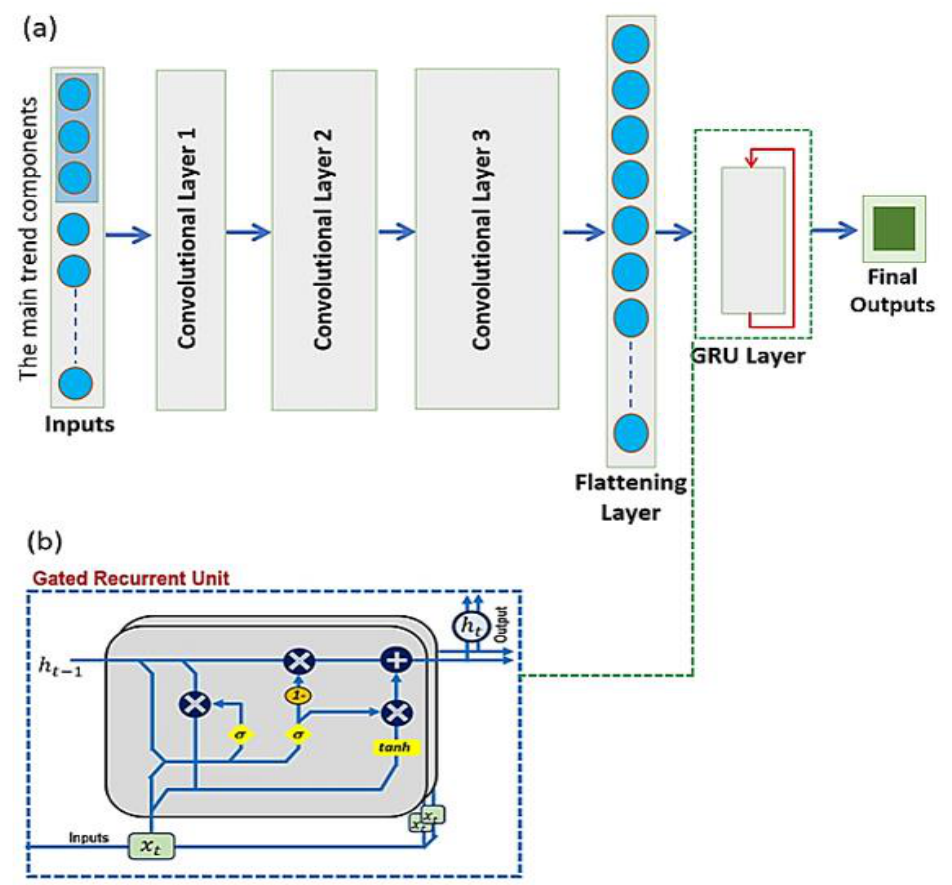
Figure 6. Topographical structure of the objective model used for forecasting MSL ( a ) 3-layered Convolutional Neural Network (CNN) and ( b ) 2-layered Gated Recurrent Unit Network (GRU).